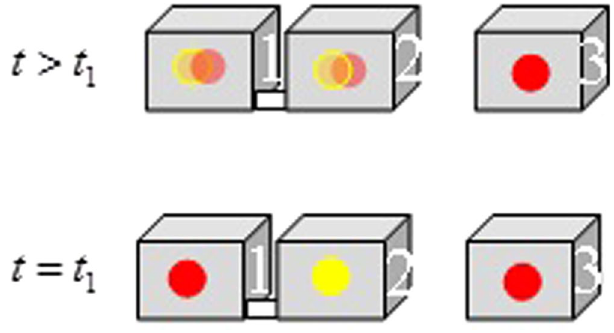
Figure 3. The story told by weak values. At t = t 1 the weak values within the three boxes are 1, − 1, and 1. Later in time, the weak values within the first two boxes “mix”, ( i.e. the left becomes < 1 and the right becomes >− 1, but their sum remains 0) and the weak value in the third box remains